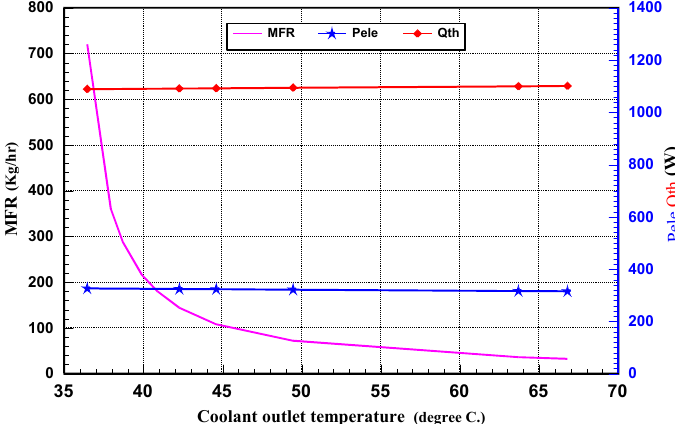
Figure 20. Variation of the mass flow rate, electrical and useful thermal powers with the cooling outlet water temperature (at constant T inl = 35 °C).